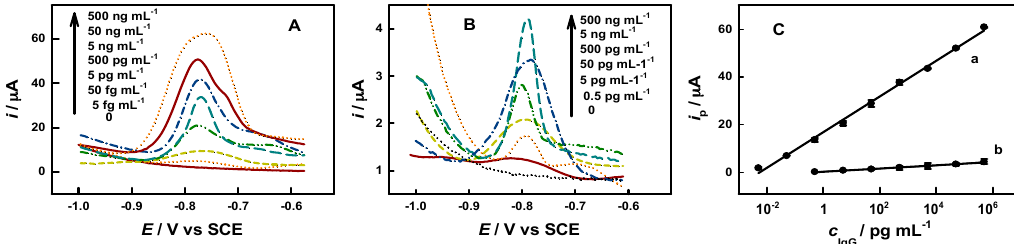
Figure 2. Differential pulse ASV curves for IgG immunoassay ( A , B ) and corresponding calibration curves ( C , n = 3). Panel A and curve a in panel C are for our protocol. Panel B and curve b in panel C are for the conventional solution-replacement protocol.